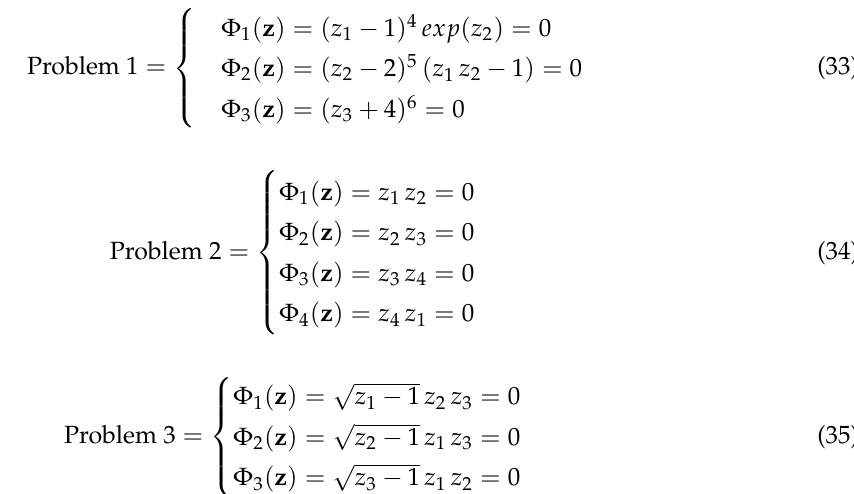
Table 1. Problem 1: initial guess = [ 2,1, − 2 ] , m = [ 4,5,6 ] . CCO: computational convergence